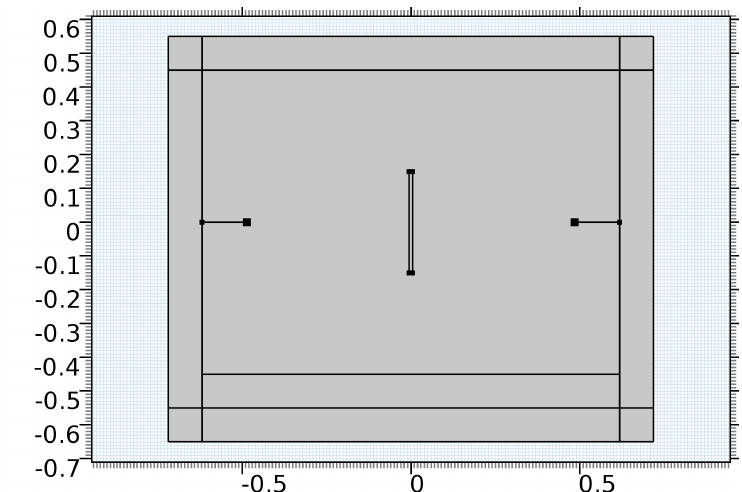
Figure 6. Computational domain of the problem: a rectangular region is bounded by PML (top, bottom, left and right), with the floor just above the bottom PML. The MUT is centered in the middle of the domain; the Tx antenna is on the left and the Rx antenna is on the right. The in − plane coordinates x (horizontal) and y (vertical) are in